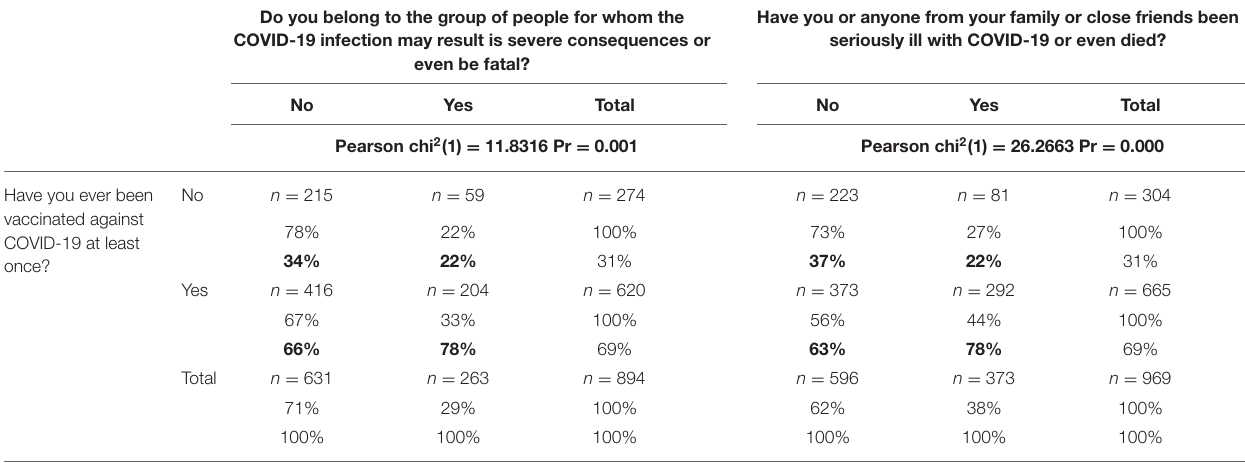
TABLE 1 | Vaccination status of people in the context of their exposure to the COVID-19 illness (15). Do you belong to the group of people for whom the COVID-19 infection may result is severe consequences or even be fatal?